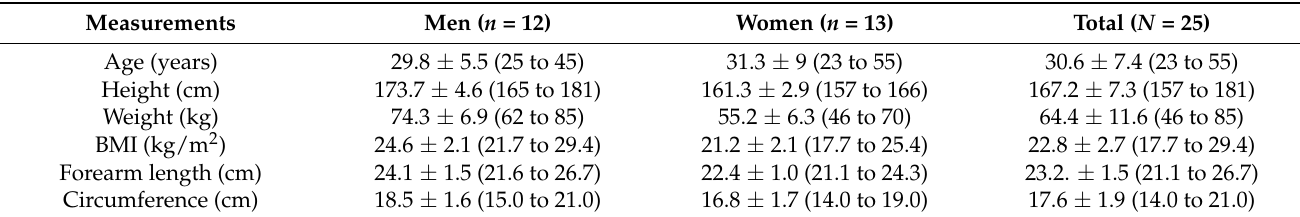
Table 1. Demographic characteristics of participants.